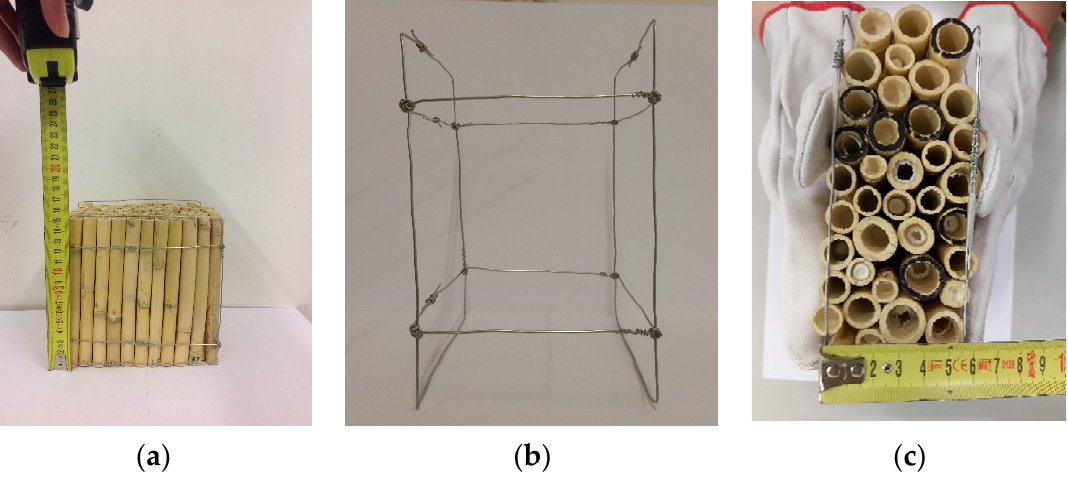
Figure 3. Main steps for making the giant-reed boards used in the thermal evaluation: ( a ) giant-reed board; ( b ) steel wireframe; ( c ) accommodation of giant reeds into the frame.